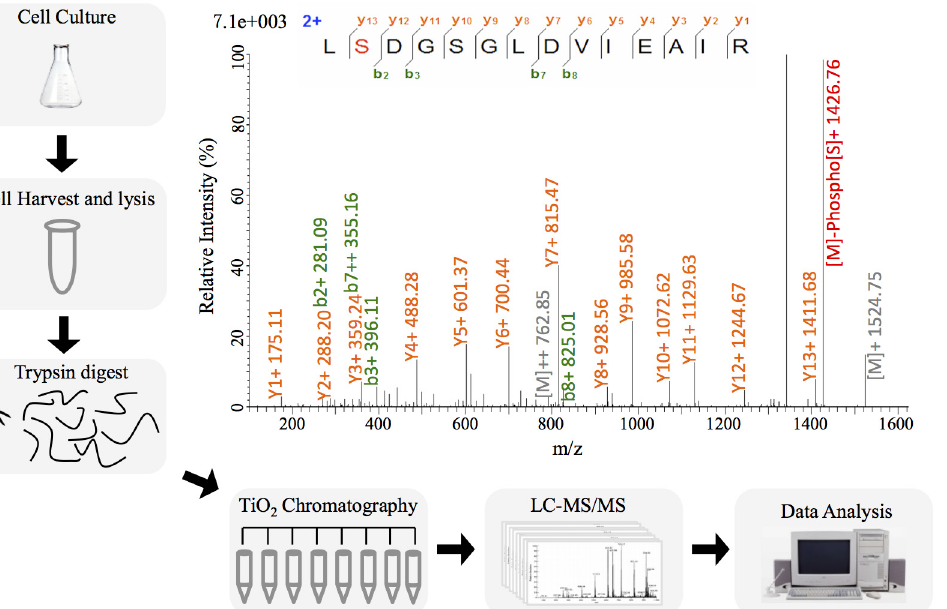
Fig 1. Overview of the workflow and a representative MS/MS spectrum. MS/MS spectrum of the phosphopeptide L(pS)DGSGLDVIEAIR from the Ser- phosphorylated two-component response regulator ActR are shown, and the most abundant fragment ion corresponds to neutral loss of phosphoric acid (98 Da) from the phosphorylated Ser in the intact